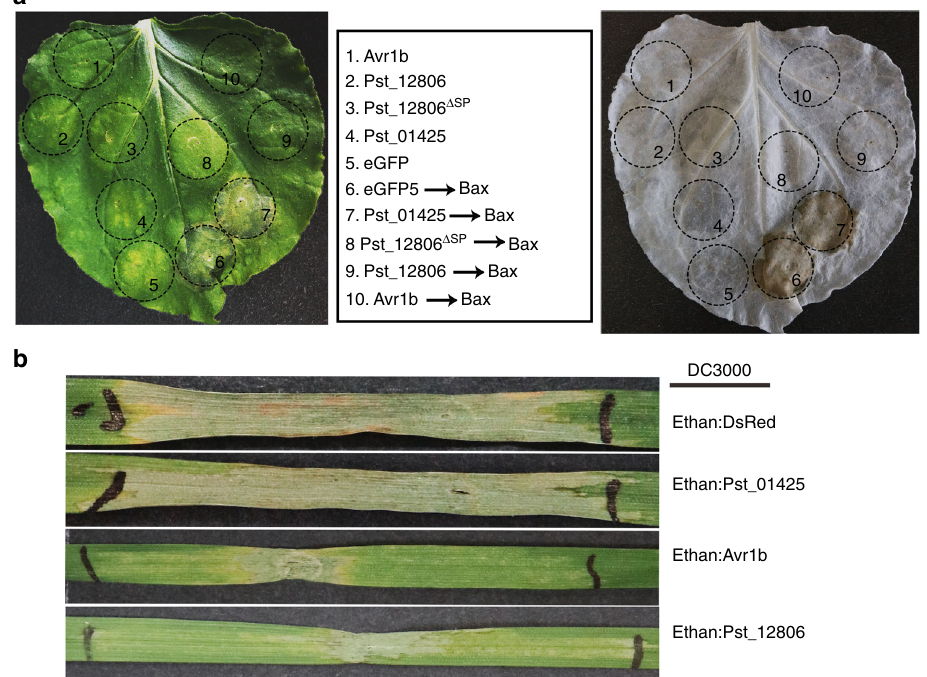
Fig. 2 Suppression of Bax- and bacteria-triggered cell death by Pst_12806. a Suppression of Bax-triggered cell death on N . benthamiana leaves. Pst_12806 was transiently expressed in leaves 24 h prior to in fi ltration with cells expressing Bax. The same leaf was examined before (left) and after (right) being decolorized with the destaining solution. At spots 1 – 10, agrobacterium cells expressing the labeled proteins (middle) were used for in fi ltration assays. b Transient expression of Pst_12806 delayed HR induced by bacteria in wheat. The second leaves of cultivar Chinese Spring seedlings were in fi ltrated with labeled P. fl uorescens strains (OD 600 = 1.0) and then inoculated with P . syringae strain DC3000 (OD 600 = 0.4). Representative images were photographed 3 days after inoculation with DC3000. The boundaries marked with black lines were the regions inoculated with